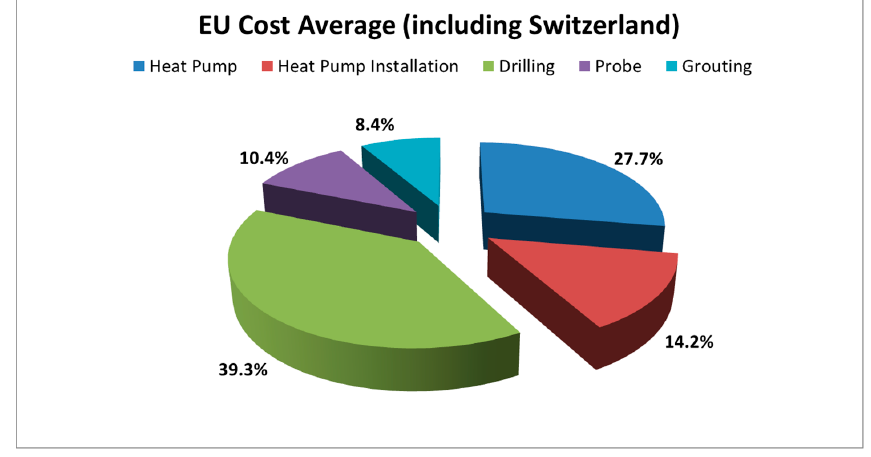
Figure 1. European average costs of a standard geothermal installation outside the house (+in-house located heat pump [1]).